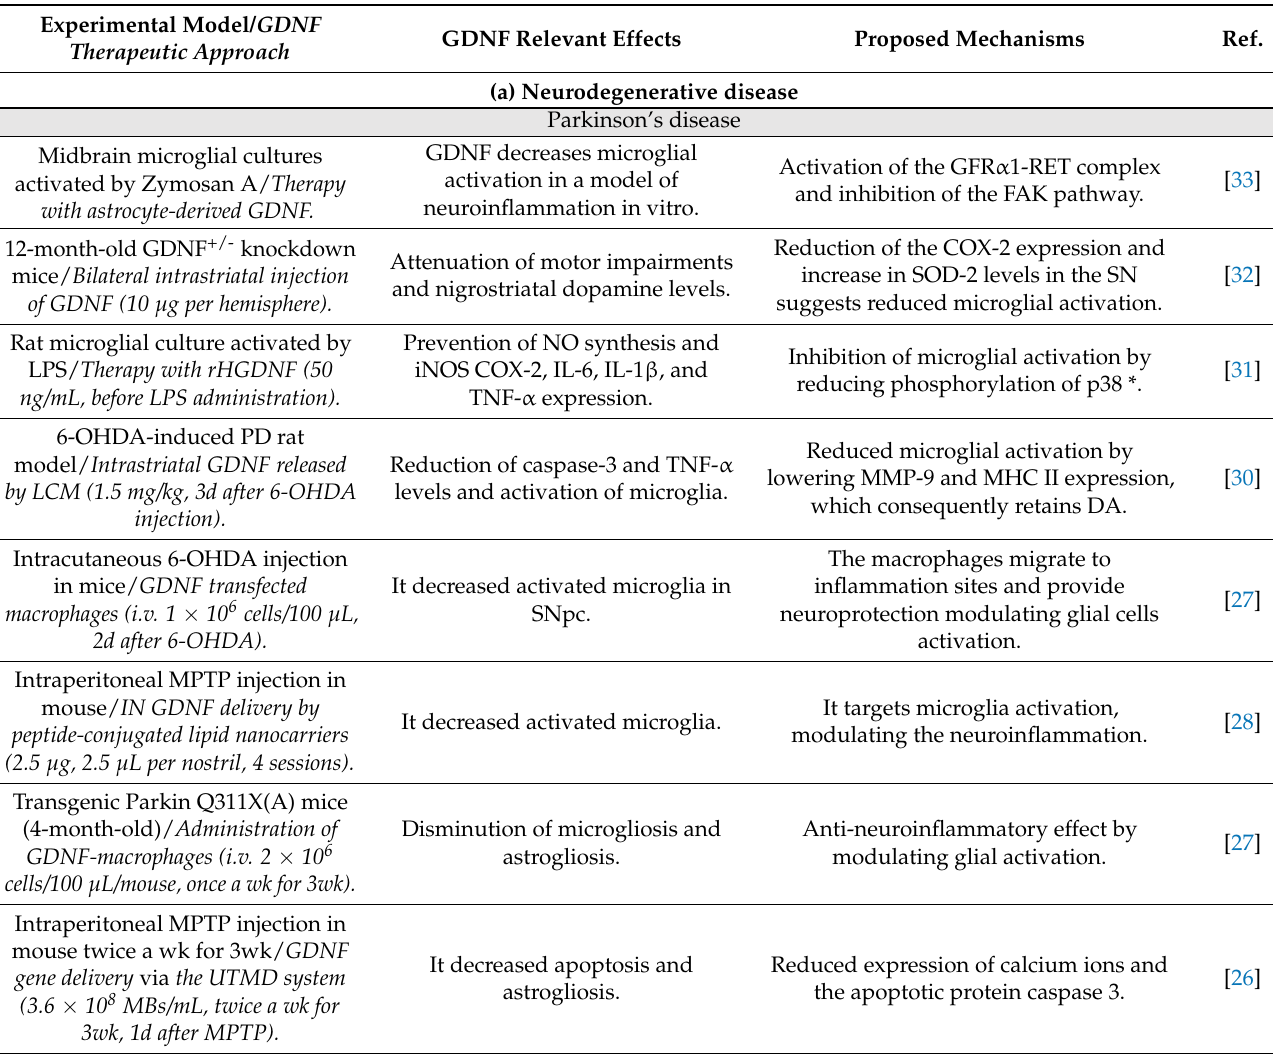
Table 4. Anti-inflammatory effect of GDNF in preclinical trials of Parkinson’s disease and other neurological diseases. Experimental Model/